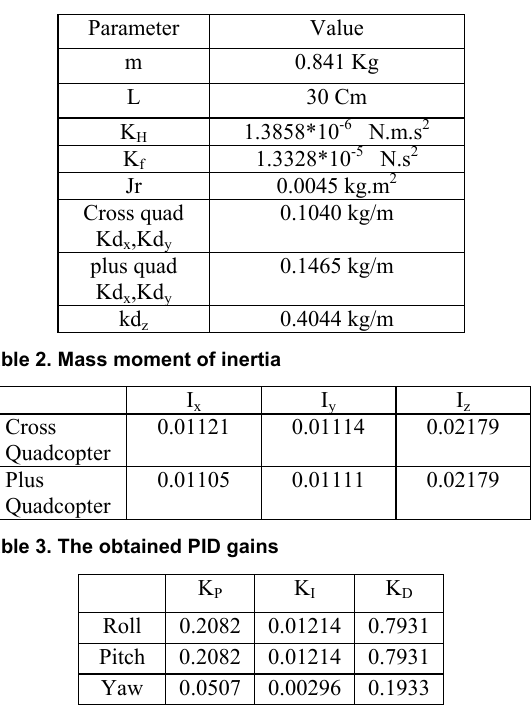
Table 1. Quadcopter parameters